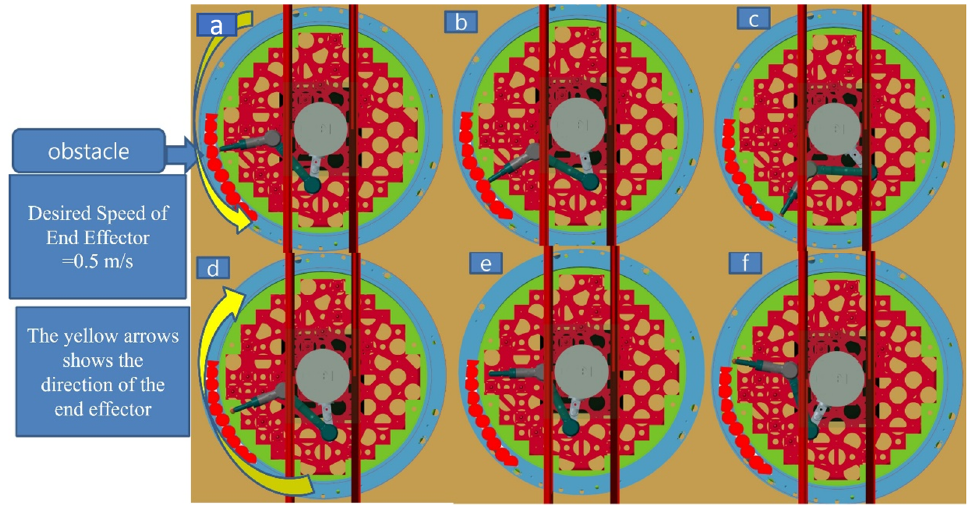
Figure 20. Continuous obstacle avoidance in simulator (end-effector); ( a – c ) collision detection (scanning); ( d – f ) collision avoidance after scanning and saving obstacle position (on return).